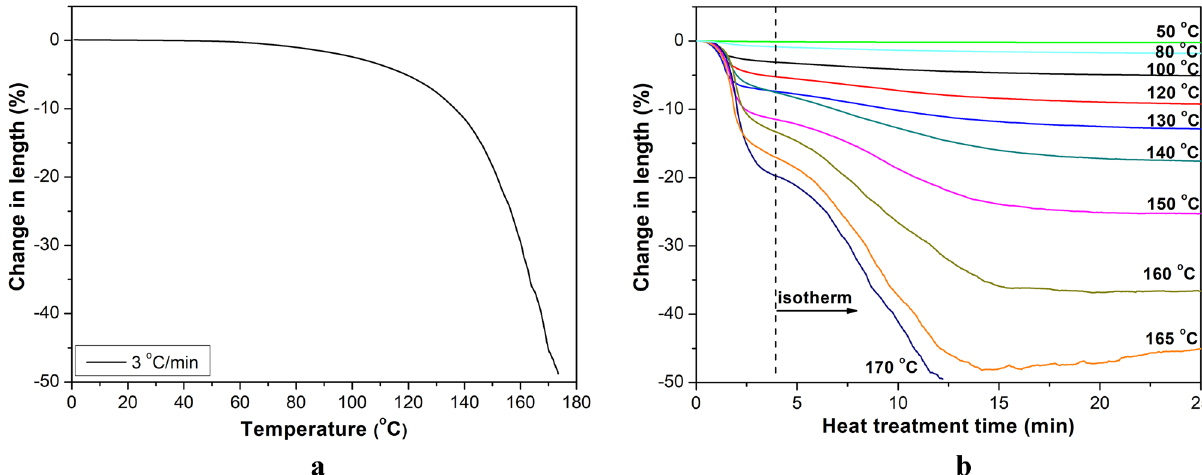
Figure 2. Relaxation tests of single fibers in DMA: Change in length as a function of temperature ( a ) and treating time at constant temperatures ( b